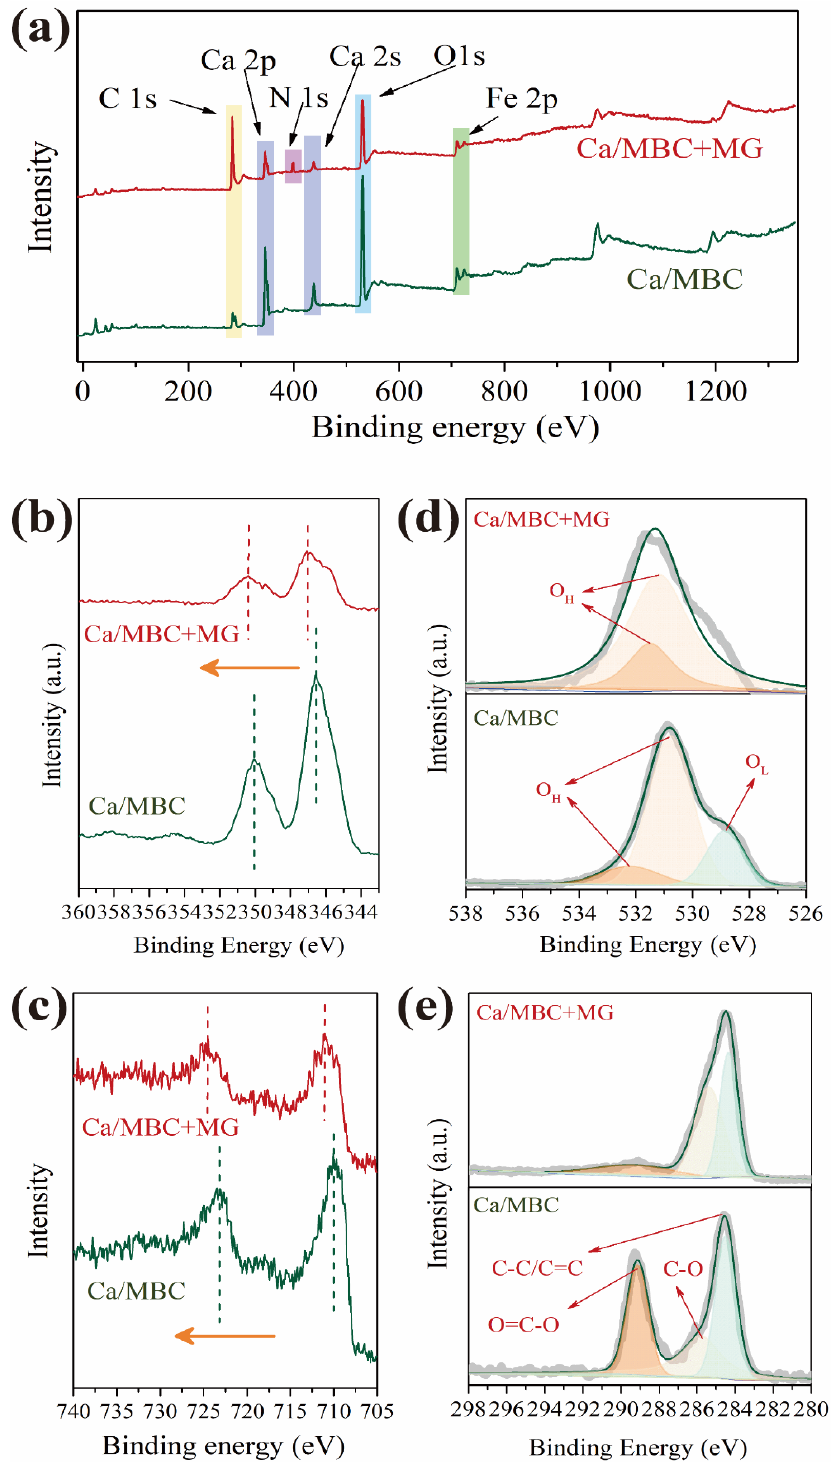
Figure 7. ( a ) XPS spectra of Ca/MBC before and after MG adsorption, ( b ) Ca 2 p , ( c ) Fe 2 p , ( d ) O 1 s , ( e ) C 1 s . ( e ) C 1 s